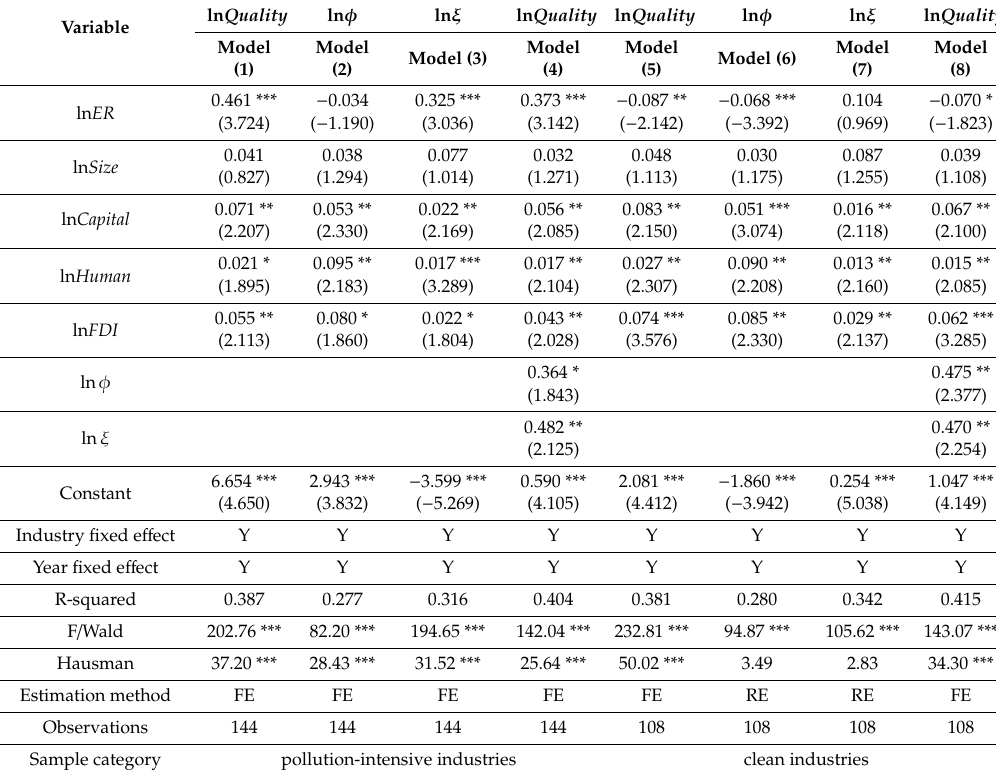
Table 7. Results of industry heterogeneity